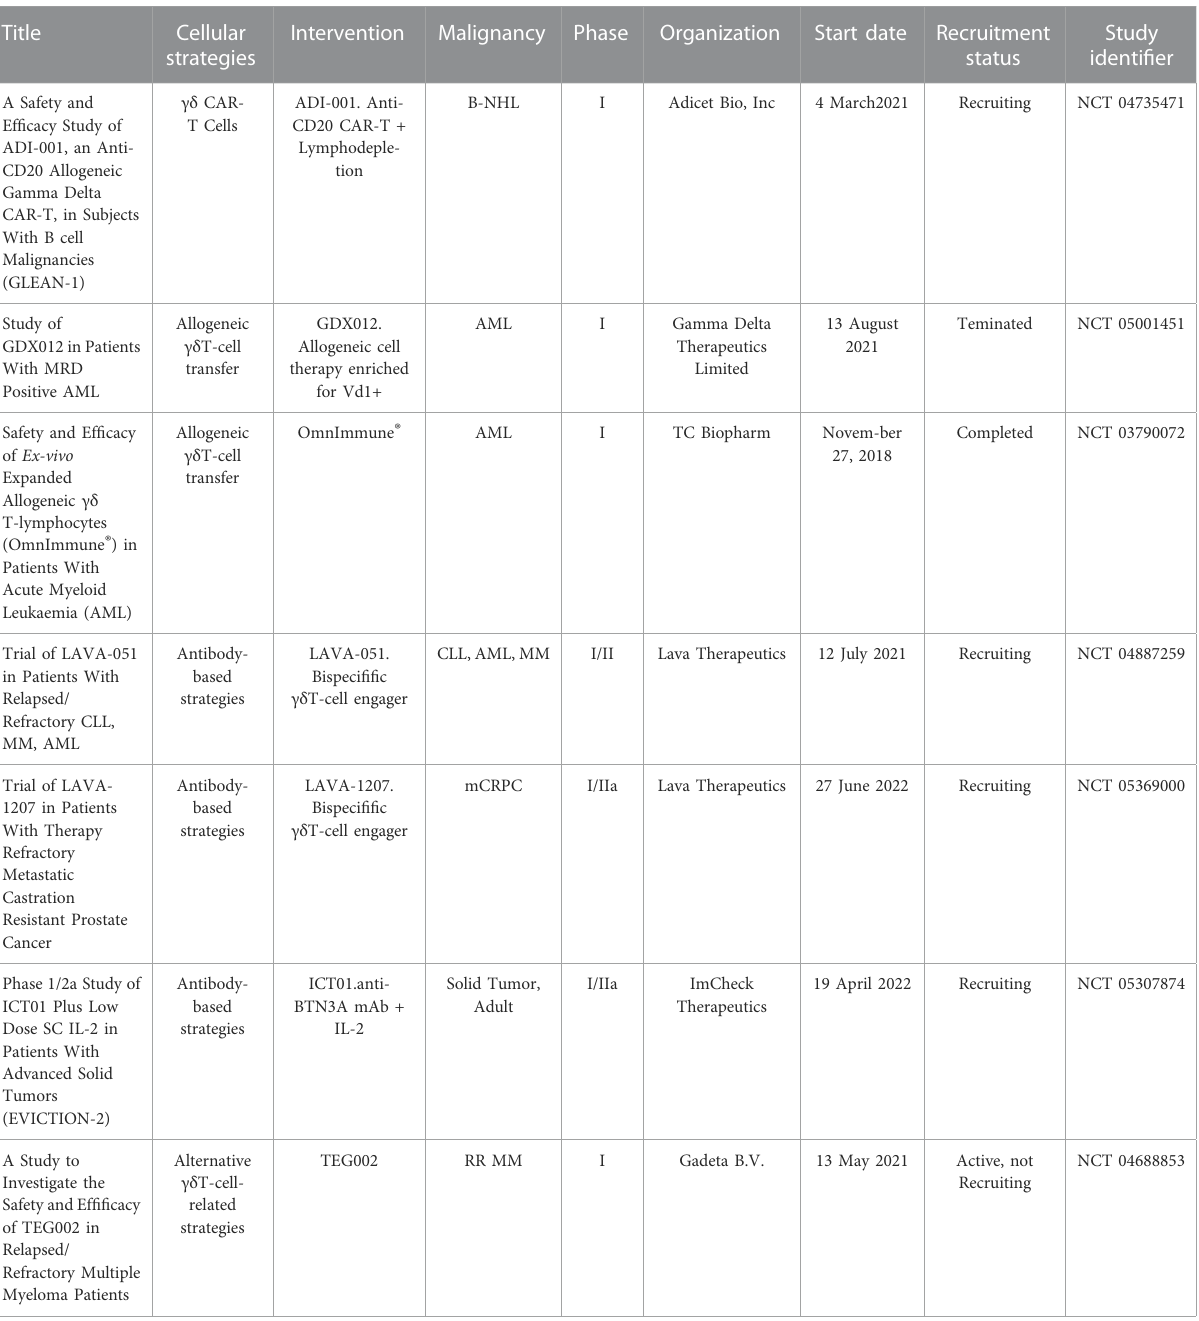
TABLE 2 Ongoing clinical trials based on γδ